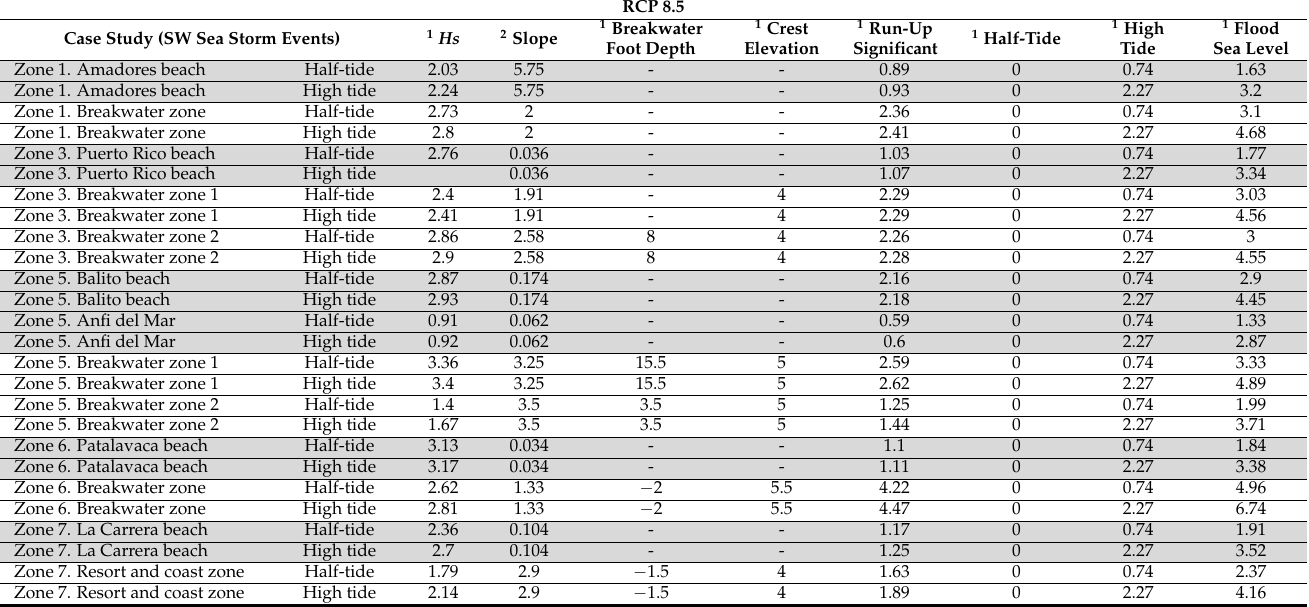
Table 3. Data used to calculate the flood sea levels projected in the RCP 8.5 scenario (last column) in the different zones studied (beaches, grey), and with two situations (half-tide and high tide), when SW sea storm events occur. RCP